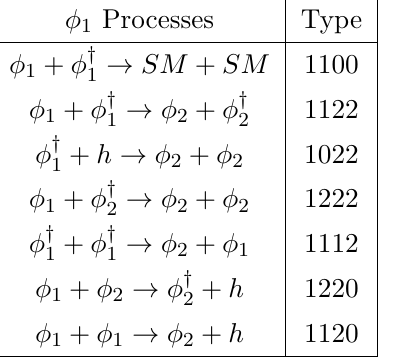
one Feynman diagram, e.g. (cid:30)